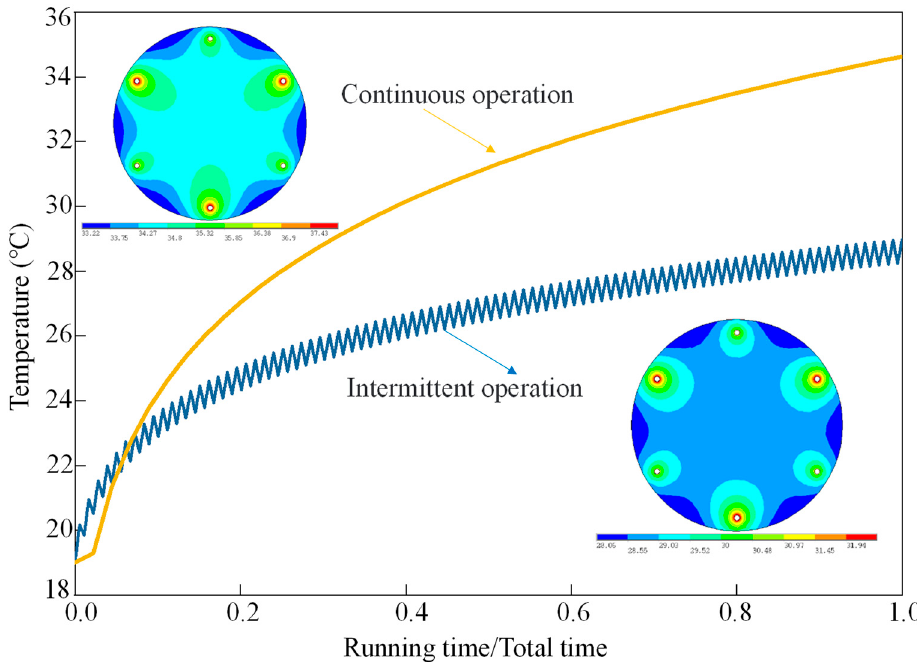
Figure 9. Temperature variation in pile under intermittent and continuous operation.